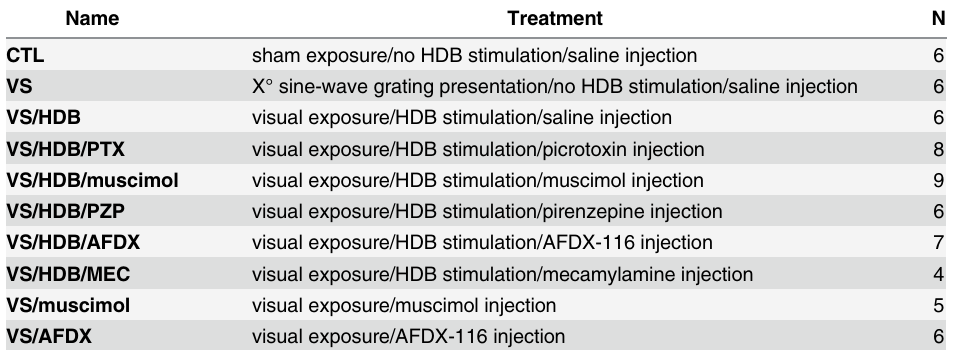
Table 1. Experimental